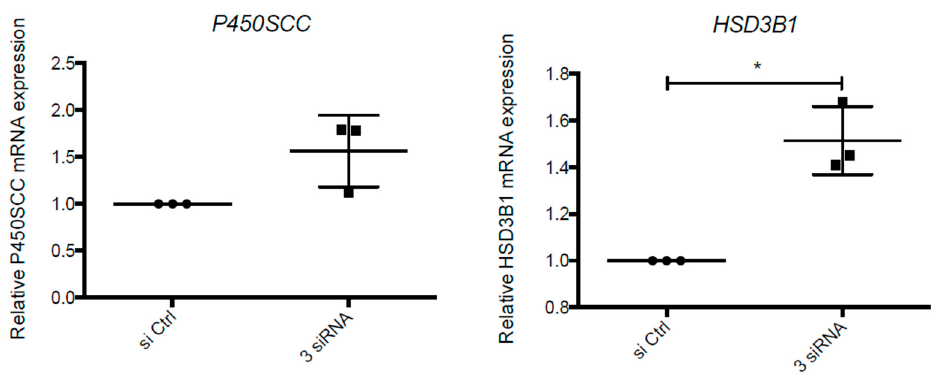
Figure 7. UPR pathways are involved in transcriptional regulation of enzymes involved in P4 synthesis. VCT cells isolated from human term placenta were transfected with siRNA against IRE1 α , PERK and ATF6 (3 siRNA) or siRNA control (si Ctrl). Total RNA was extracted and P450SCC and HSD3B1 expression were evaluated by RT-qPCR. The results are presented as mean +/ − SD of 3 independent experiments. * p < 0.05 vs. si Ctrl, two-tailed paired no parametric t